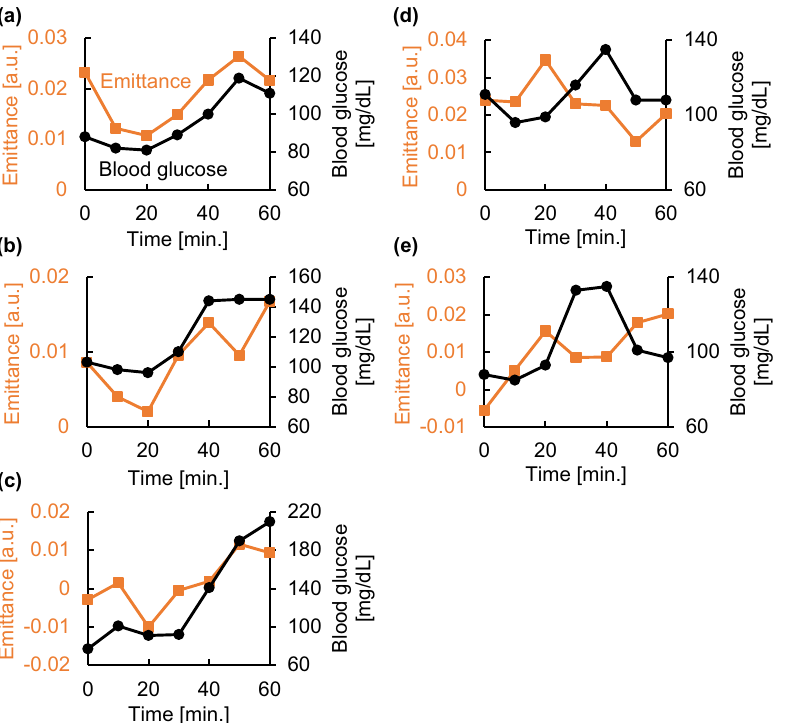
Figure 4. Temporal changes in emission and blood glucose levels based on periodic measurements taken every 10 min. (a) Time trends of emission and blood glucose levels of subject A. (b) Time trends of emission and blood glucose levels of subject B. (c) Time trends of emission and blood glucose levels of subject C. (d) Time trends of emission and blood glucose levels of subject D. (e) Time trends of emission and blood glucose levels of subject E. The emittance in ( a–e ) are the average emissions at 9.0 and 9.7 µm, corresponding to the glucose emission peaks.